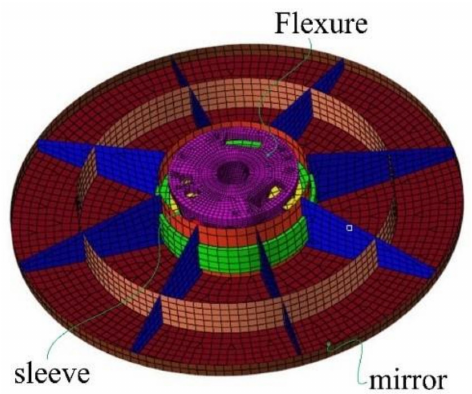
Figure 6. The FE model of the space mirror assembly.